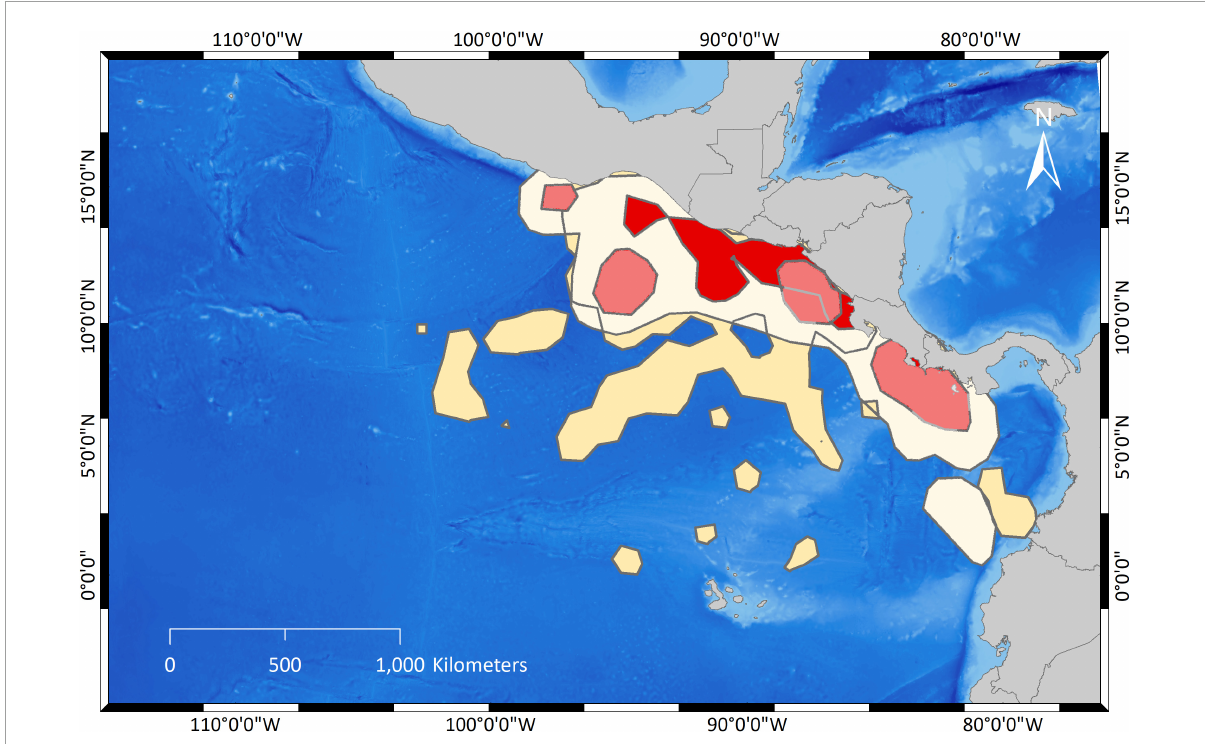
FIGURE4 Overlap of UDs from arribada and solitary olive ridley females. Dark red polygons demark PVC 50 (=core areas) for arribada females, light red polygons PVC 50 for solitary females. Dark sand-colored polygons demark PVC 95 for arribada females and light sand-colored polygons PVC 95 for solitary females.